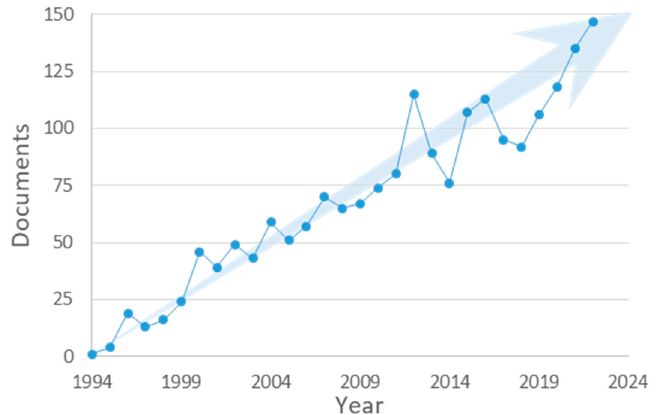
Figure 1. The number of published articles per year from the Scopus bibliometric database [10] using “pesticides”, “gas chromatography”, and “SPME” as descriptors. The number of publications by the end of the current year is extrapolated from the existing data.